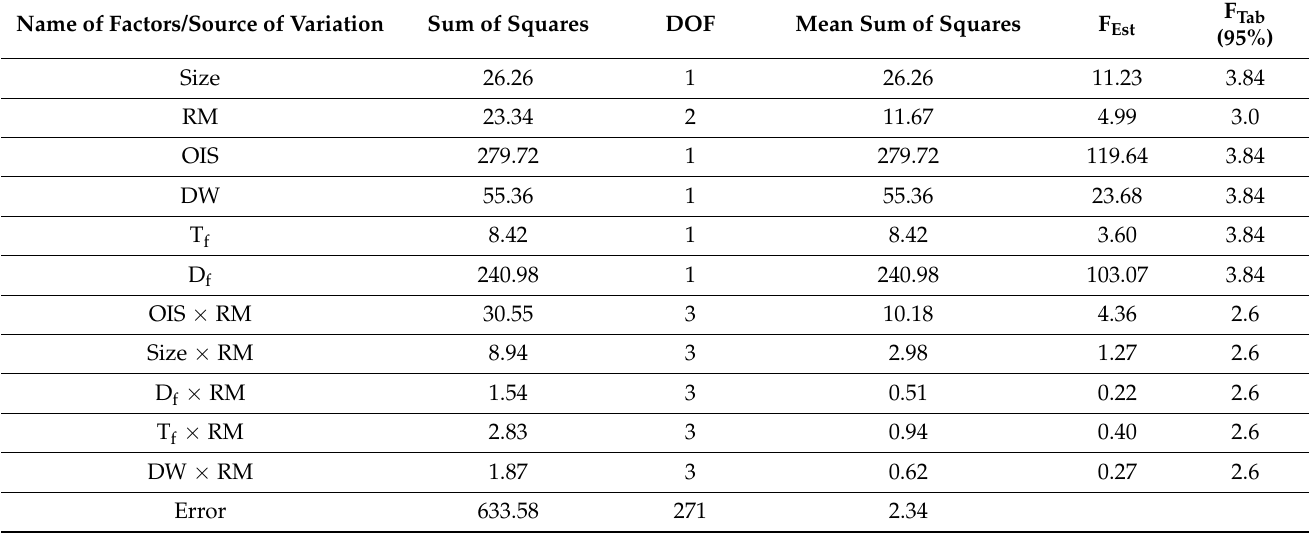
Table 6. Statistical analysis of the factors influencing disruptions and their